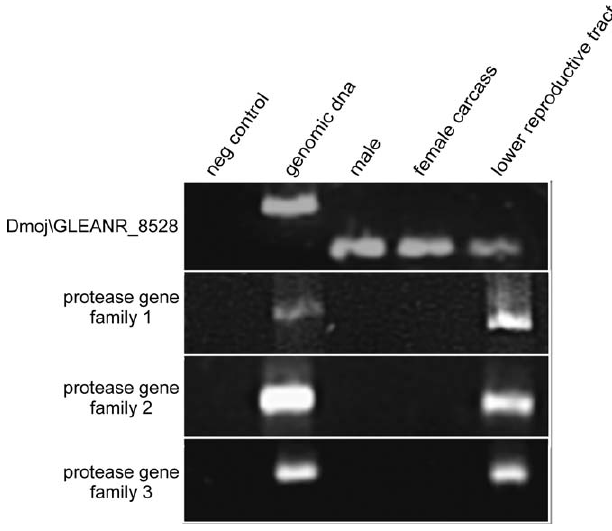
Figure 4. RT-PCR of Three Gene Families Universal primers for each gene family were used to amplify genomic DNA, and cDNA from males, female carcasses (no lower reproductive tract), and lower reproductive tracts (for complete gels see Figure S1). doi:10.1371/journal.pgen.0030148.g004 PLoS Genetics |